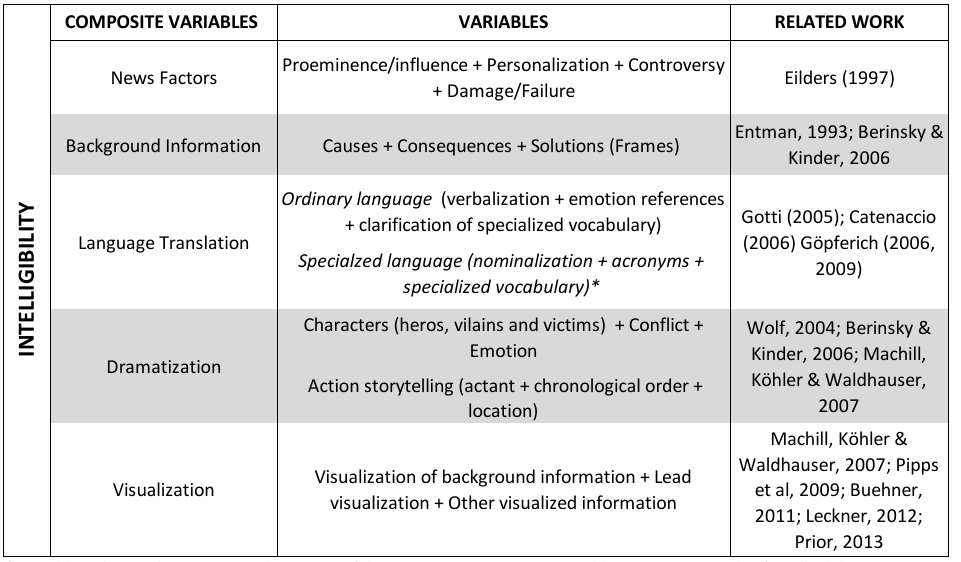
Table 2. Composite Variables for